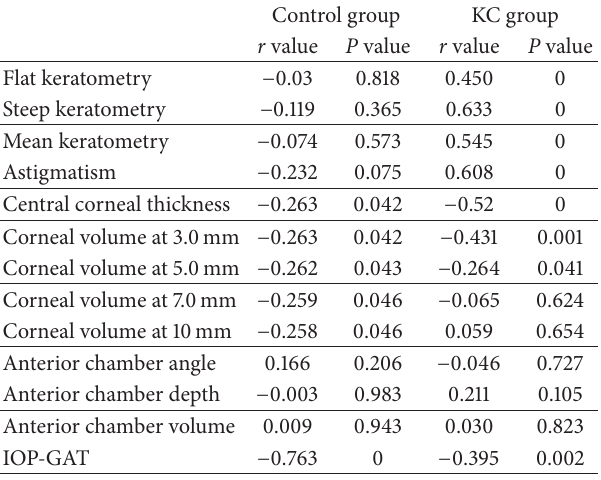
Table 2: Correlation coefficient between DA and tomography parameters and intraocular